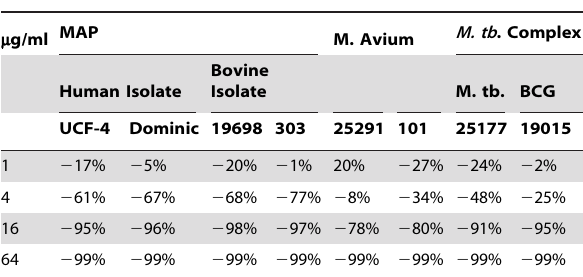
Table 7. b -Carotene.